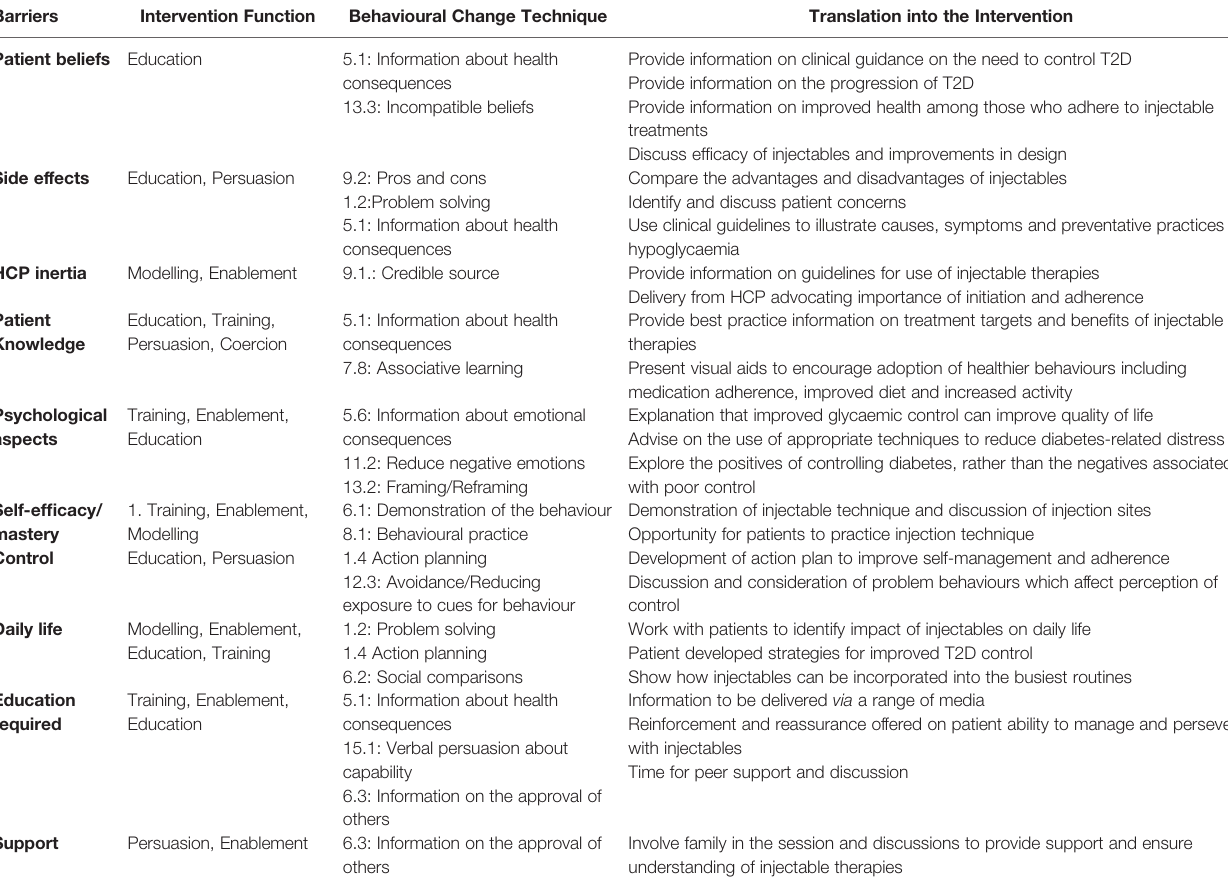
TABLE 2 | Selected behavioural change techniques: translation to